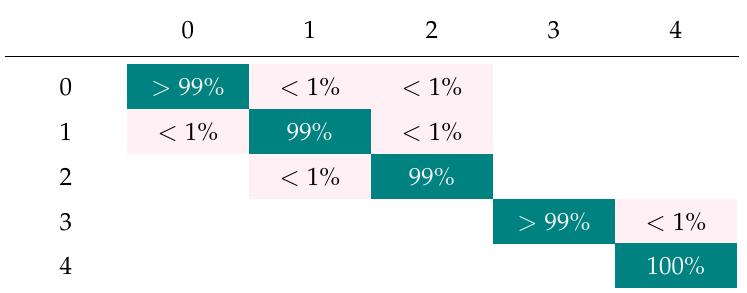
Table 10. Confusion matrix of the SVM model with ρ = 90 and C = 1, we get an accuracy of 99.9%. Label 0 corresponds to healthy, label 1 corresponds to level 1, label 2 corresponds to level 2, label 3 level 3 and label 4 corresponds to level 4. In this matrix, each row represents the instances in a true class while each column represents the instances in a predicted class. An empty blank square means